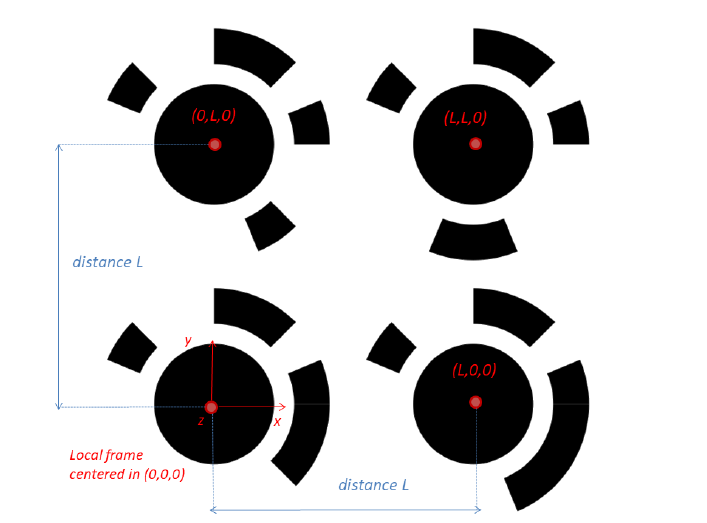
Figure 1. Representation of the coded pattern and its local frame. The detection algorithm detects the red points q 1 = [ 0,0,0 ] (cid:62) , q 2 = [ 0, L ,0 ] (cid:62) , q 3 = [ L ,0,0 ] (cid:62) , and q 4 = [ L , L ,0 ] (cid:62)